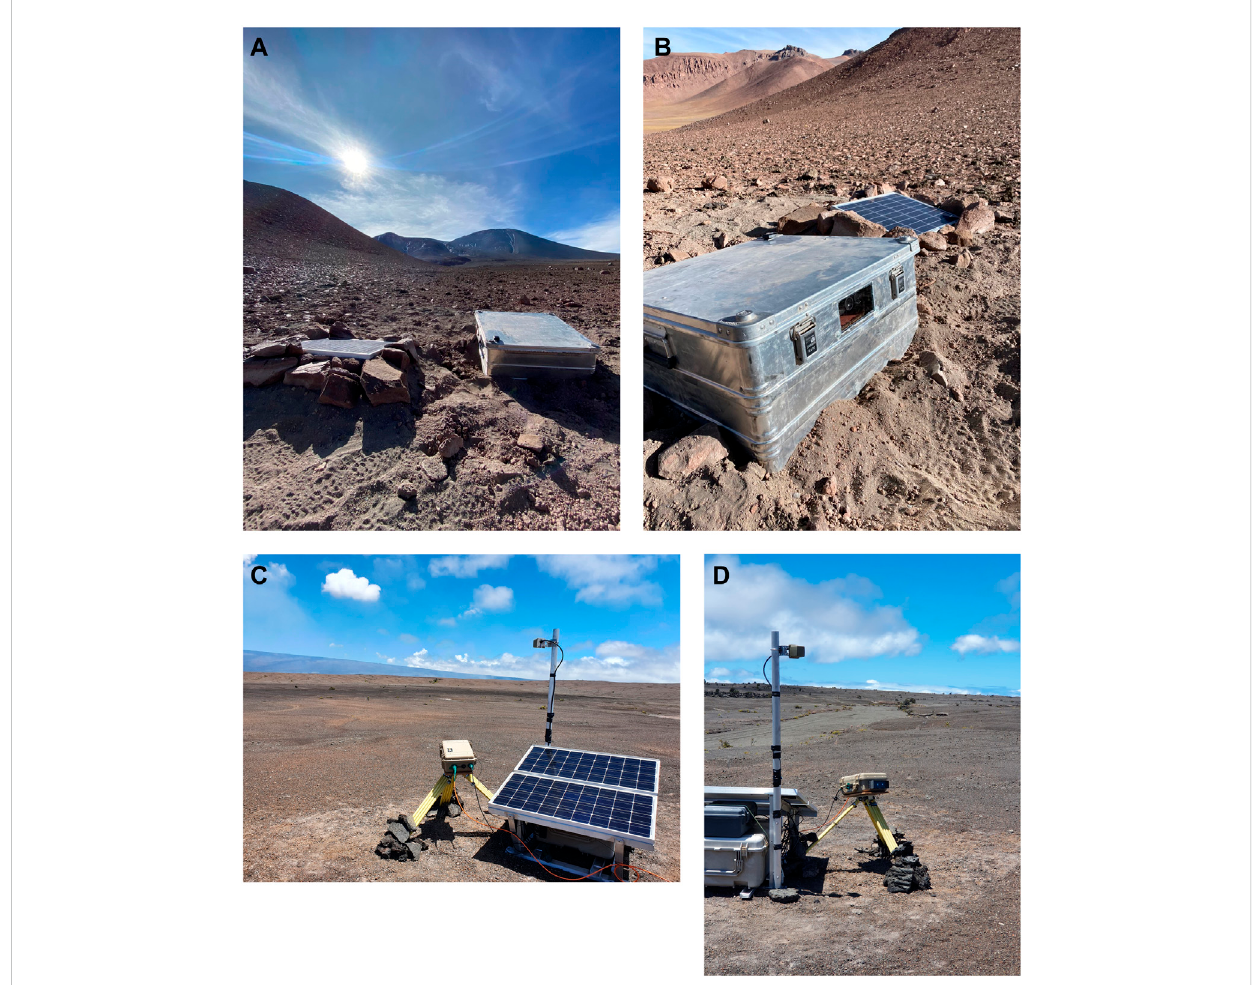
FIGURE 3 (A, B) Instrument installation on Lascar volcano, Chile (Photo credit: T. Wilkes). (C, D) Instrument installation on K ī lauea volcano, Hawaii, United States (Photo credit: T.